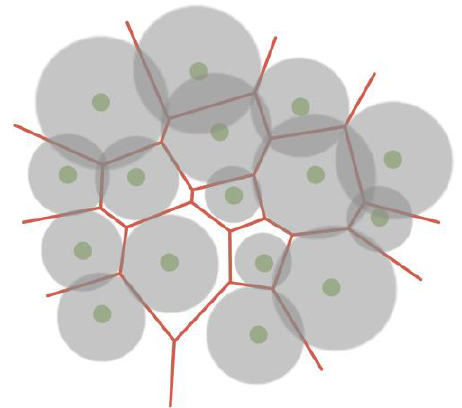
Figure 17. Voronoi force diagram, taking into account the weights of centroids, where the parameter of the atom determines the weight.